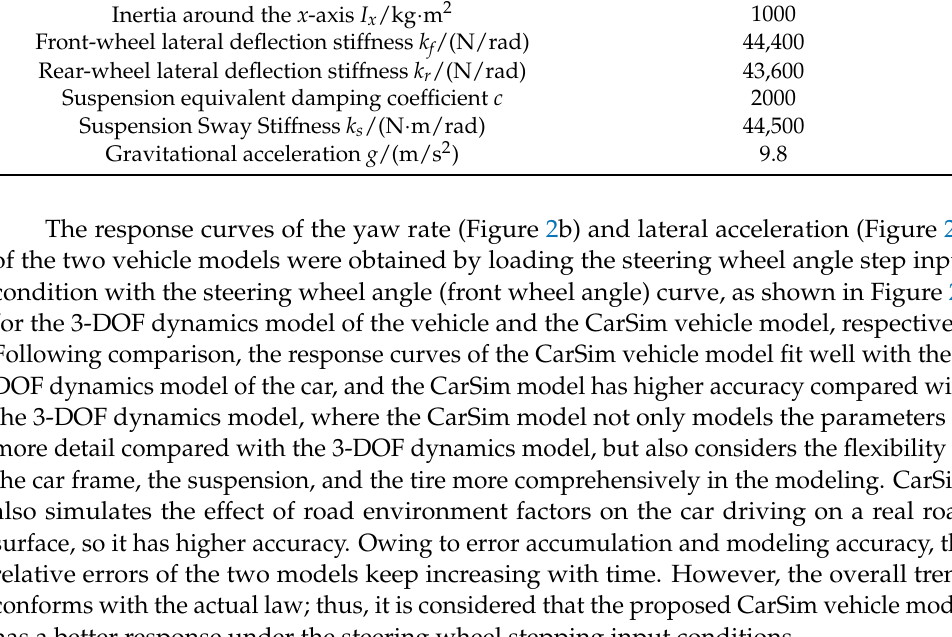
Table 1. Parameters of intelligent inspection vehicles for forest land.